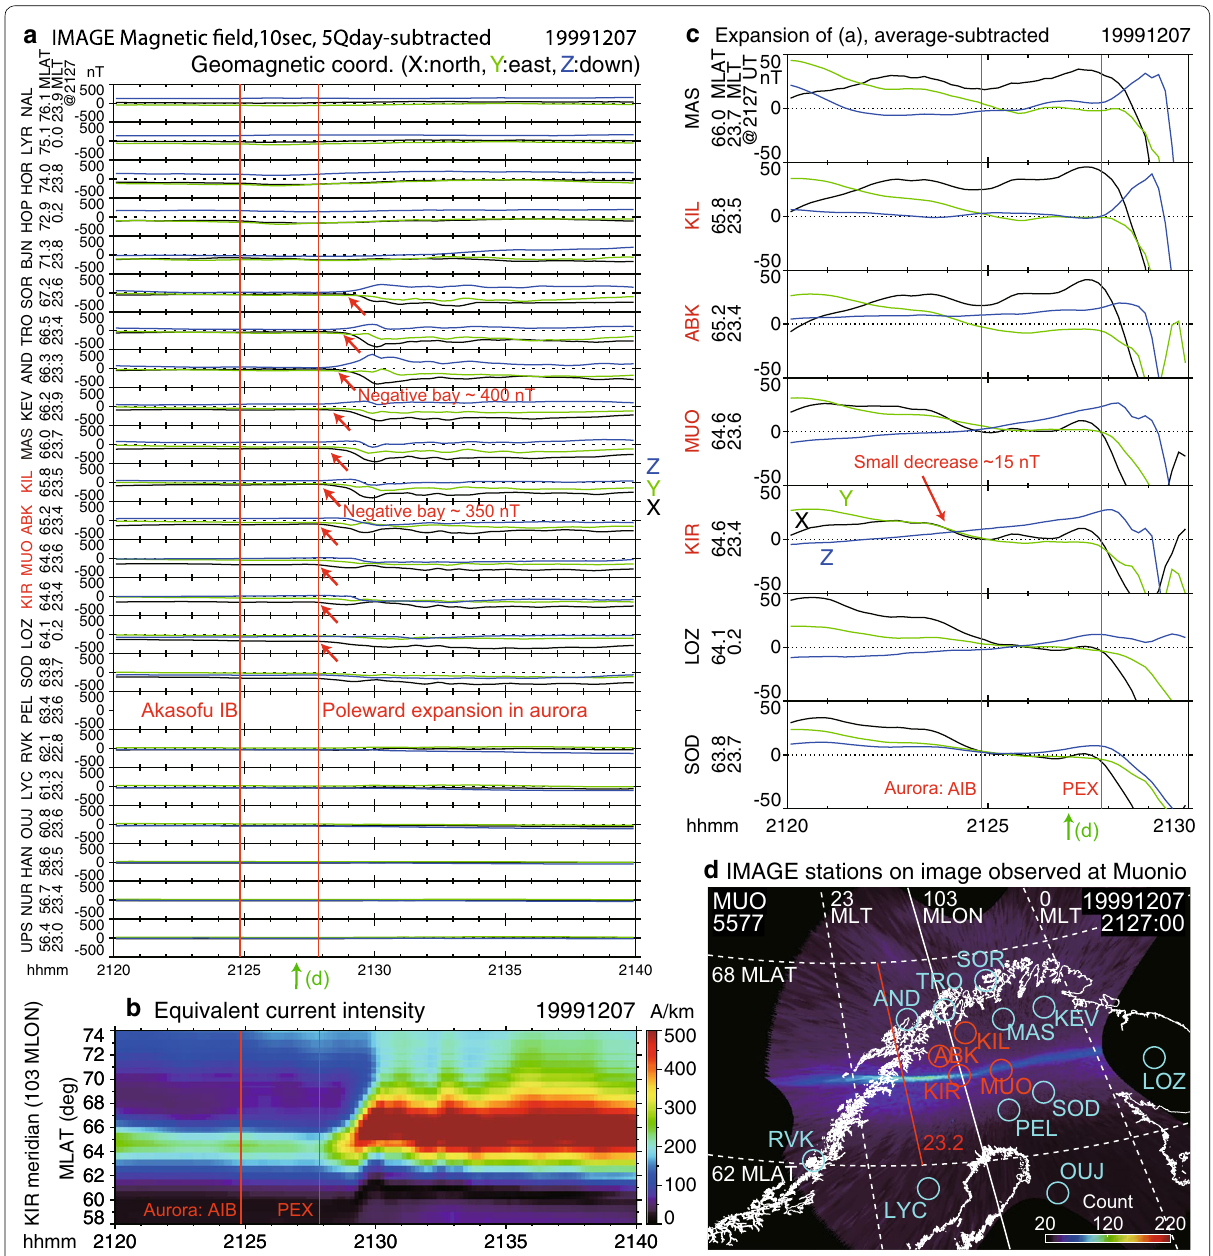
Fig. 9 IMAGE ground magnetic observations near the substorm onset longitude in Europe. a Variations in the northward ( X ), eastward ( Y ), and downward ( Z ) components of the magnetic field in geomagnetic coordinates. The panels are presented in order of the observatory latitude, with the top panel corresponding to the highest magnetic latitude (MLAT) station. The magnetic local time (MLT) of each observatory at 2127 UT is shown at the left of each panel. Red vertical lines indicate the times of the Akasofu initial brightening (AIB) at 2124:50 UT and the poleward expansion at 2127:50 UT, both at [23.2 MLT, 64.6 MLAT] in the all-sky images (ASIs). The five-quiet-day baseline was subtracted for each observatory. The negative bay began at 2128 UT. b Intensity of the equivalent current at an altitude of 110 km, shown along the KIR station meridian ( 103 ◦ magnetic longitude). The equivalent current was derived by using the same data set as a , except that the van de Kamp (2013) baseline was used. c Expansion of a for weak variations beginning at 2124 UT. The average of the displayed interval was subtracted for each observatory. d Locations of some IMAGE magnetic stations overlaid on an ASI at Muonio captured during the